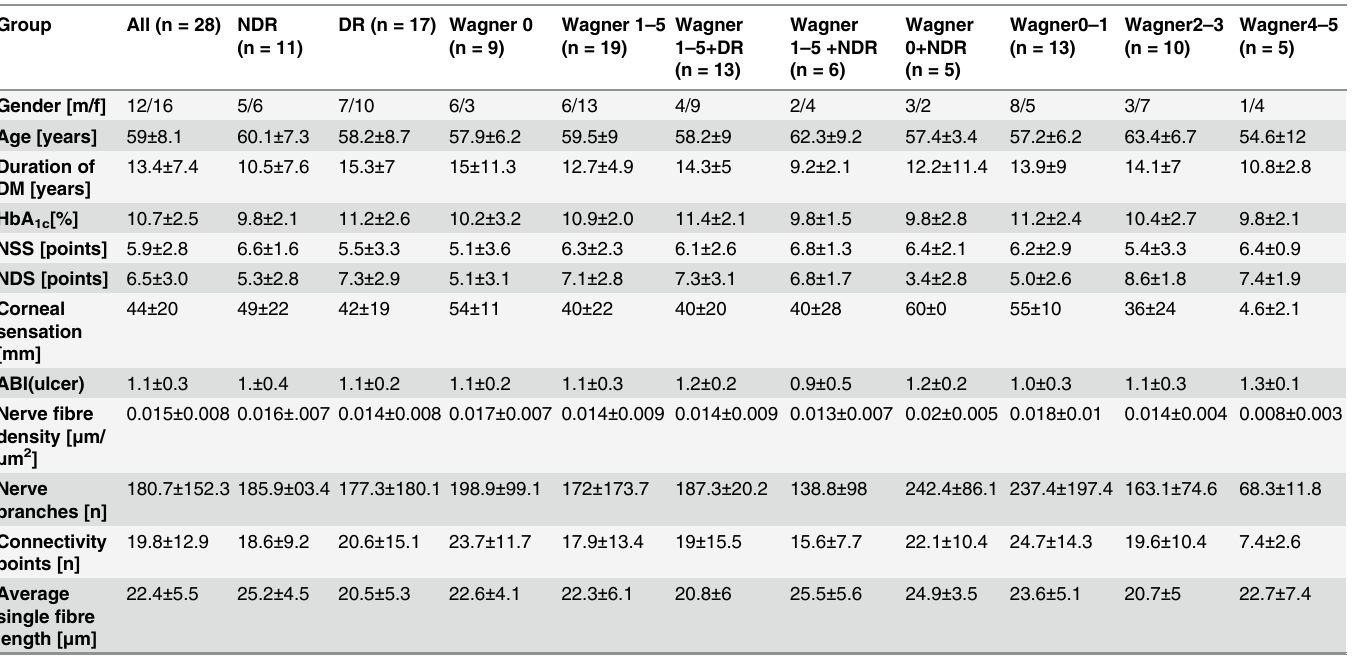
Table 1. Clinical and demographic data for all participants and for various subgroups (data presented as mean ± SD). Group All (n = 28) NDR (n =